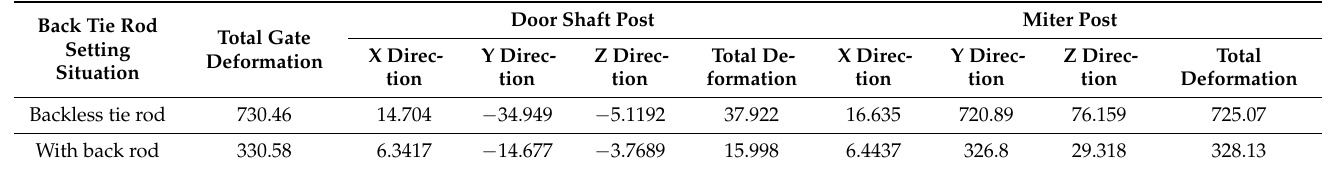
Table 5. Maximum deformation of the gate with and without a back tie rod in a state of 3 mm.